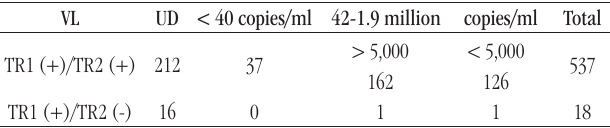
taBLE 1 − HIV RT results and its relationship to HIV-1 VL detection